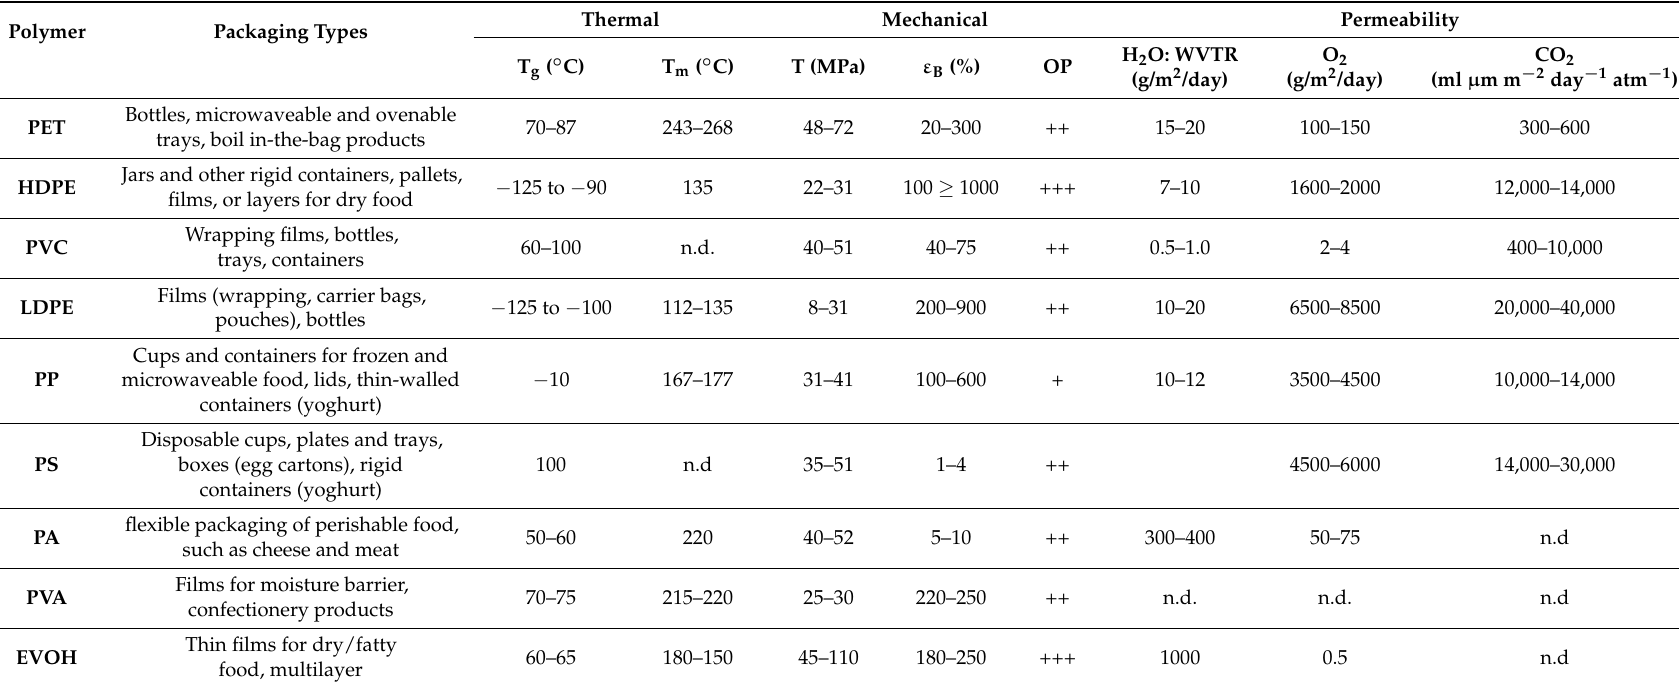
Table 1. Physical properties of polymers applied in packaging and food